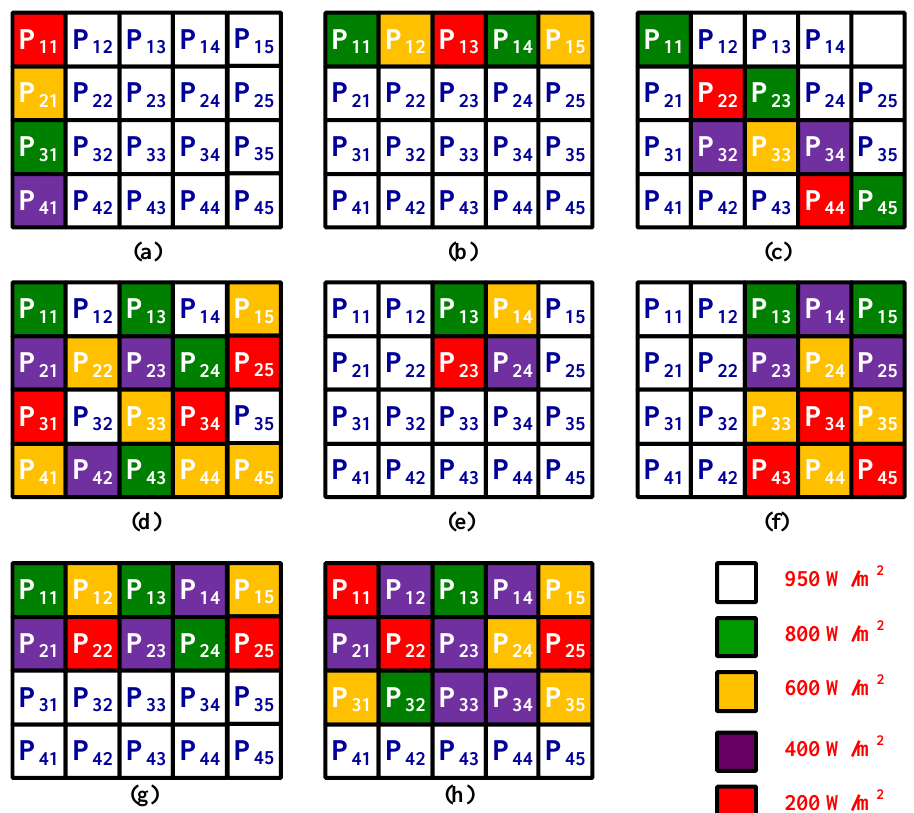
Figure 9. ( a ) Uneven row shading; ( b ) uneven column shading; ( c ) diagonal shading; ( d ) random shading ( e ) short and narrow shading; ( f ) short and wide shading; ( g ) long and narrow shading; ( h ) long and wide shading. Table 3. Output Power of Series-Parallel Array Configuration. Series-Parallel Configuration Simulation S. No Shading Type